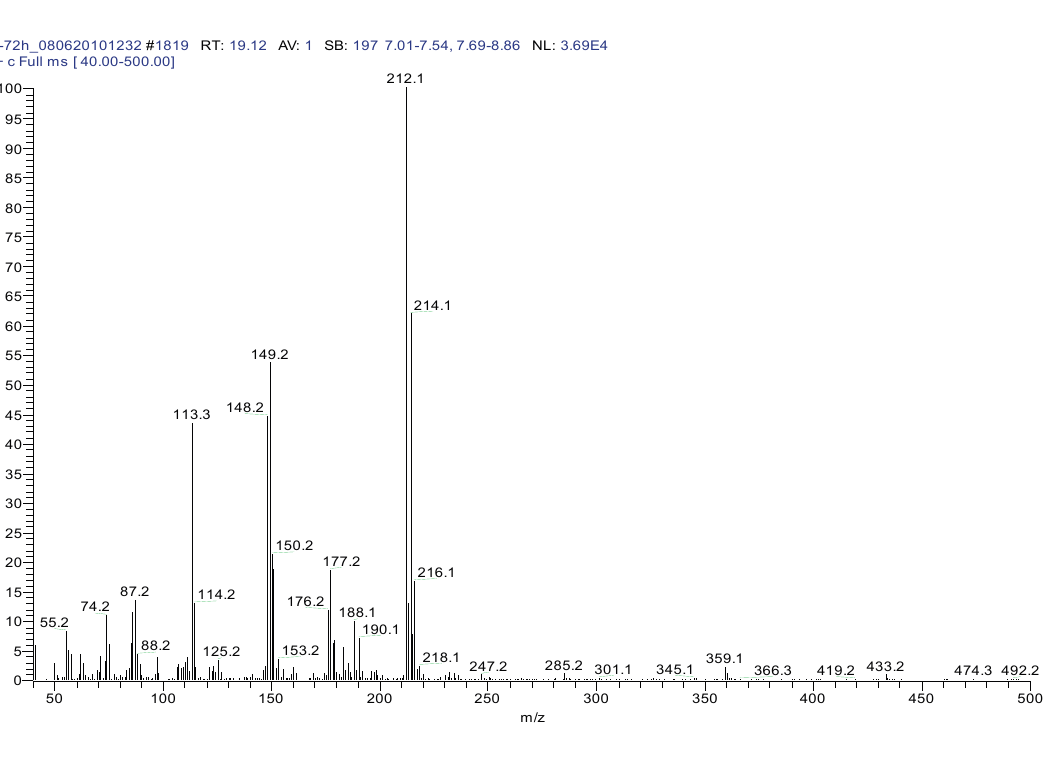
Figure 7. MS spectrum of epoxy-chlorinated